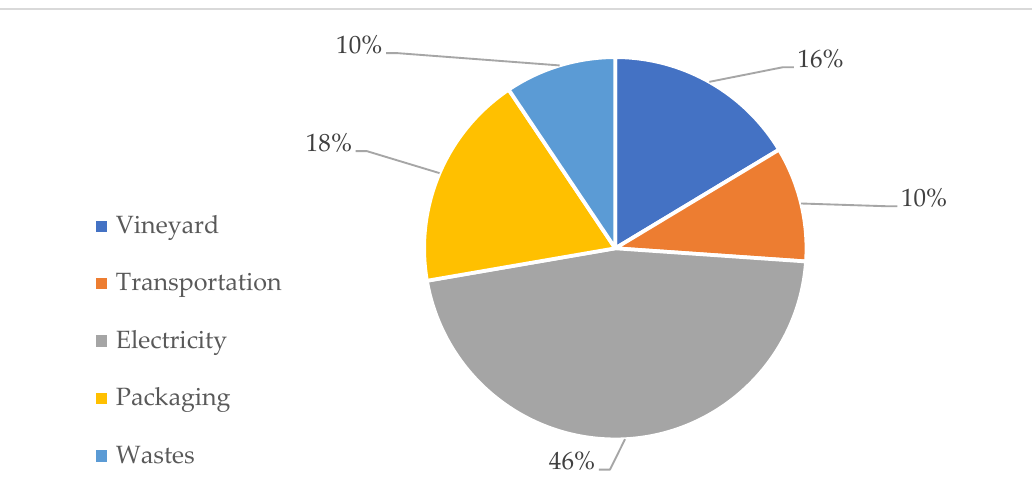
Figure 3. Contribution of the vineyard, transportation and fuels, electricity, packaging and wastes to the total emissions (kg CO 2 -eq) for the production of Xynisteri white wine.